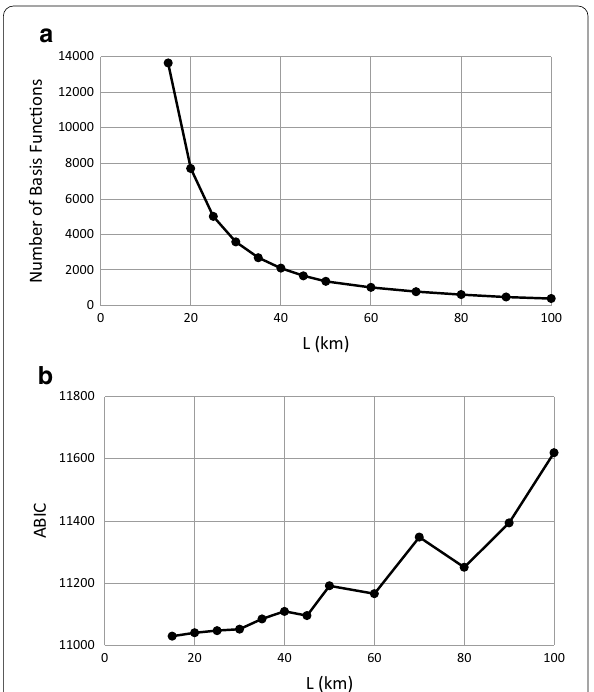
Fig. 7 Relation between the basis-function interval L and estimation performance in the ABIC method. a Relation between the interval L and the number of basis functions M . b Relation between the interval L and the value of